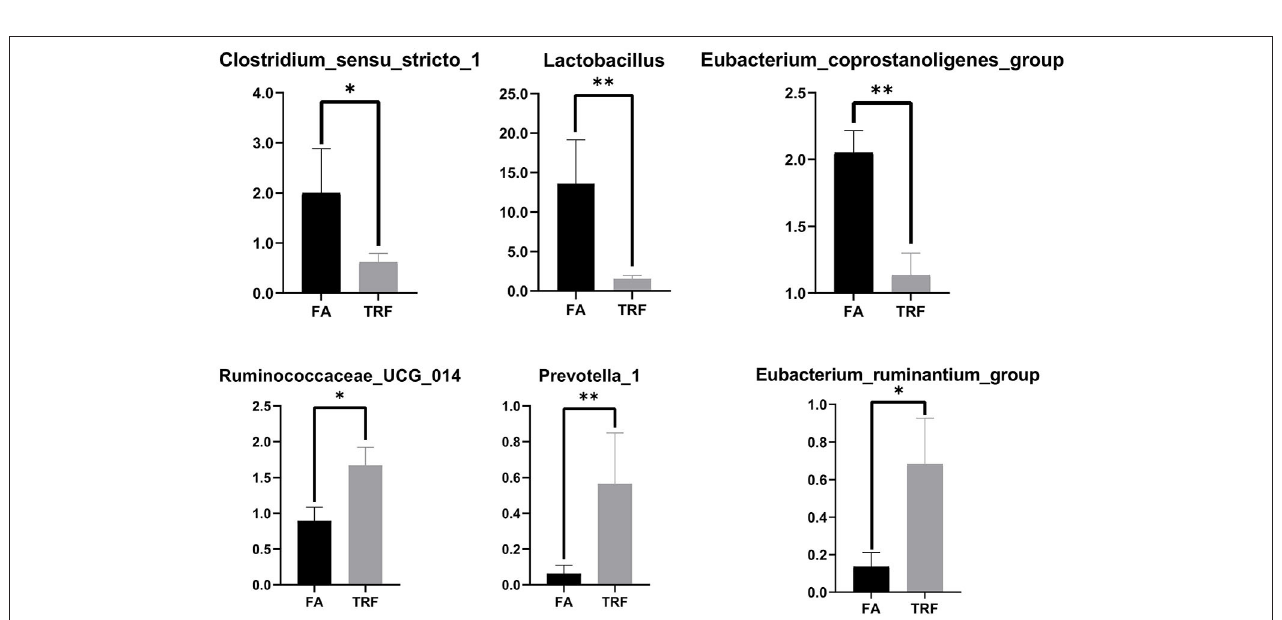
FIGURE 3 | The relative abundances of bacteria in colonic digesta of growing pigs at the genus level. FA, free access group; TRF, time-restricted feeding group. **Indicates a significant difference between the FA and TRF groups with P < 0.01; while *indicates a significant difference with P < 0.05.